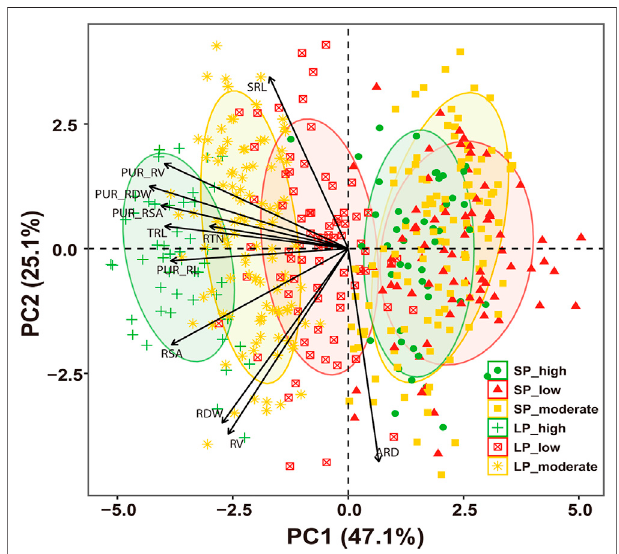
FIGURE 4 | Principal component analysis (PCA) of genotype and genotype × trait interaction. SP_high, high P uptake rate per plant under suf fi cient-P treatment; SP_low, low P uptake rate per plant under suf fi cient-P treatment; SP_moderate, moderate P uptake rate per plant under suf fi cient-P treatment; LP_high, high P uptake rate per plant under low-P treatment; LP_low, low P uptake rate per plant under low-P treatment; LP_moderate, moderate P uptake rate per plant under low-P treatment. RDW,rootdryweight perplant; TRL,totaltoot length;RSA,rootsurfacearea; RV, root volume; ARD, average root diameter; RTN, root tip number; SRL, speci fi c root length; PUR_RDW, P uptake rate per unit root dry weight;